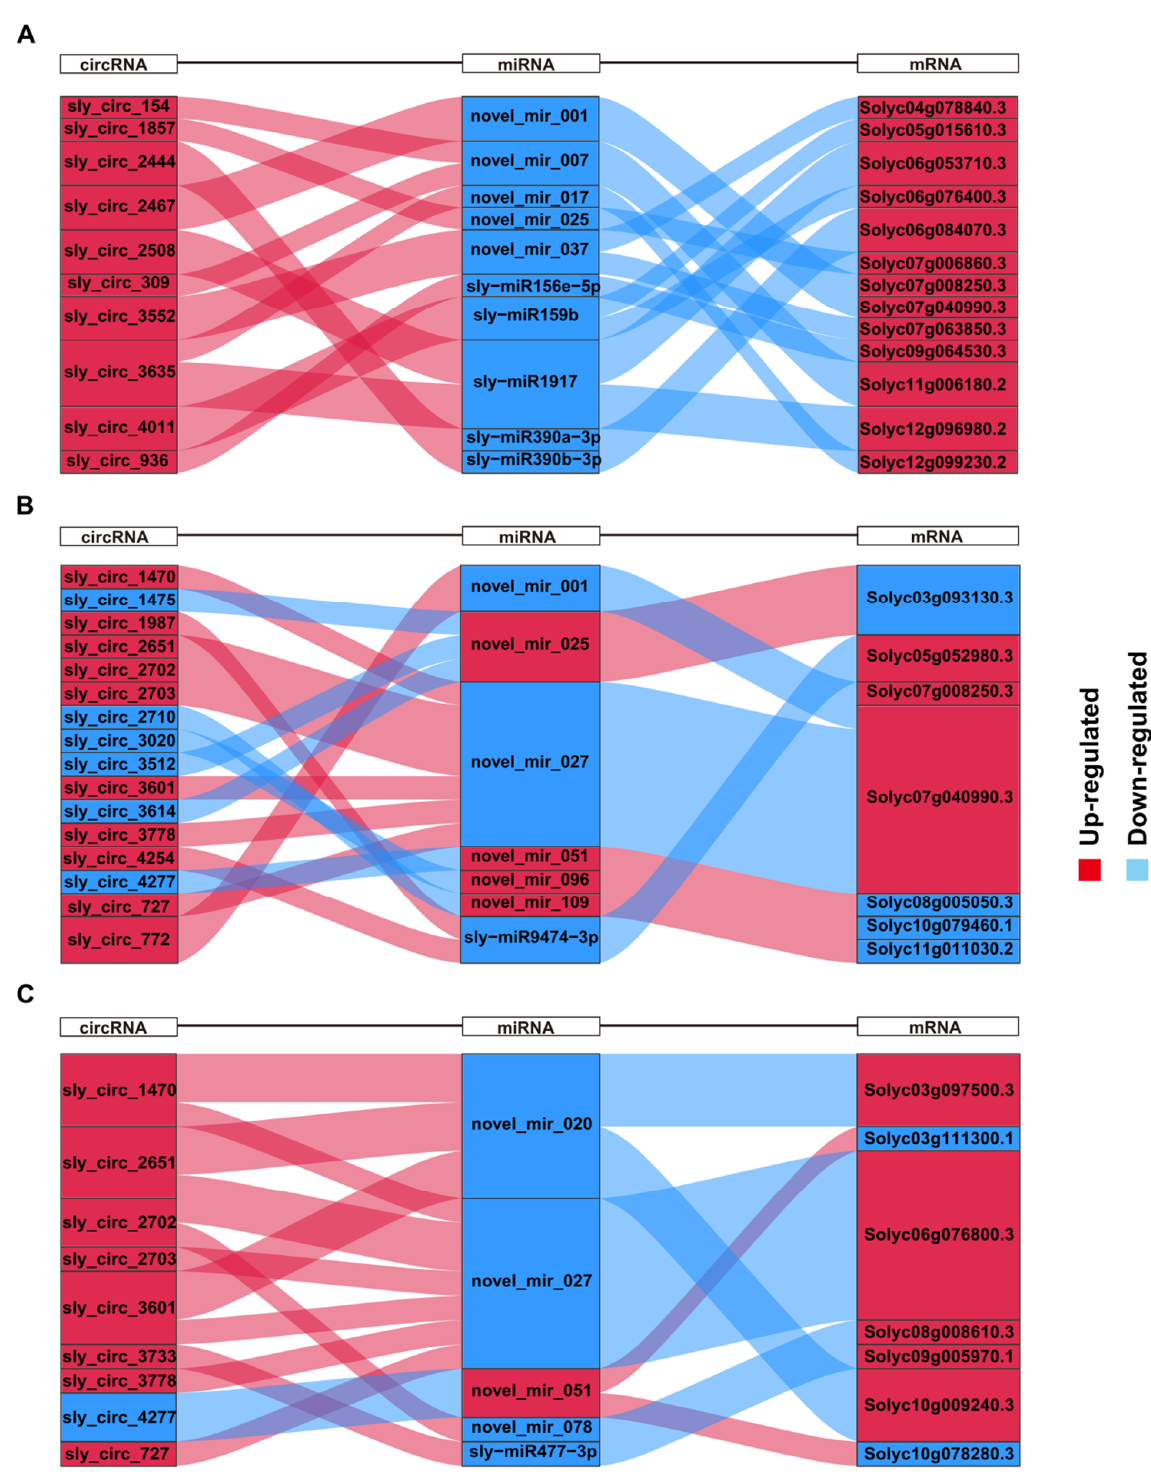
Figure 7. The Sankey plots show the ceRNA networks of three pathways. Red and blue represent up-regulation and down-regulation, respectively. ( A ) The ceRNA network of the plant hormone signal transduction pathway in M82. ( B ) The ceRNA network of the plant hormone signal transduction pathway in Solanum pennellii ( S. pennellii ). ( C ) The ceRNA network of the suberin biosynthetic process was enriched only in S. pennellii .